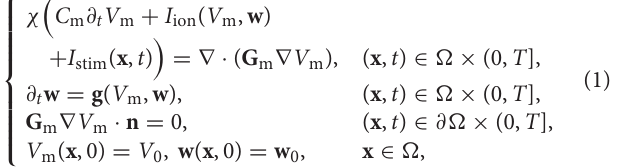
veins isolation (PVI) and PVI with roof lines (PVI+BOX), see Figure 2D . Ablation lines are non-conductive